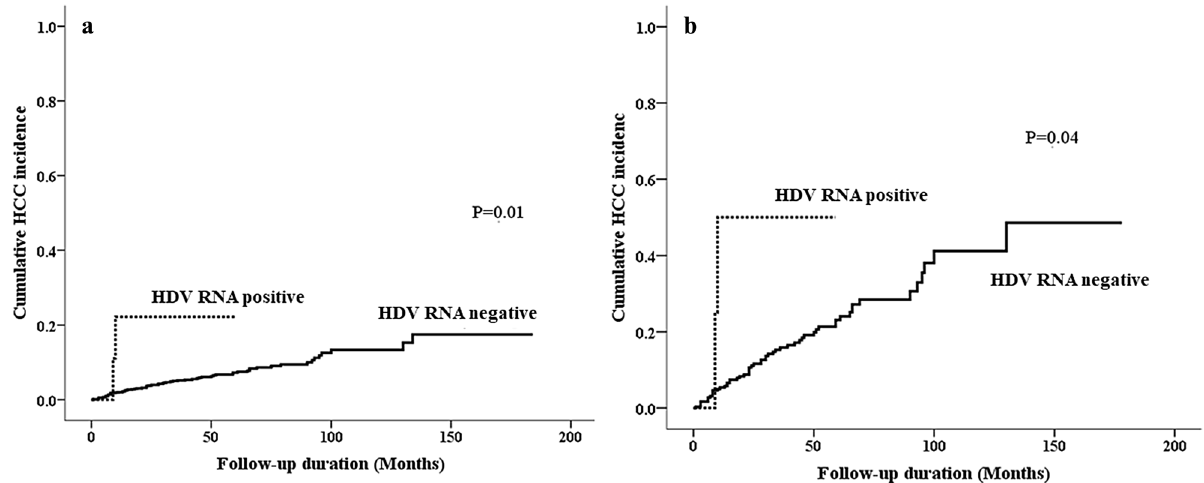
Figure 2. ( a ) Cumulative incidence of HCC in CHB patients with HDV RNA (+) and HDV RNA (−). ( b ) Cumulative incidence of HCC in cirrhotic patients with HDV RNA (+) and HDV RNA